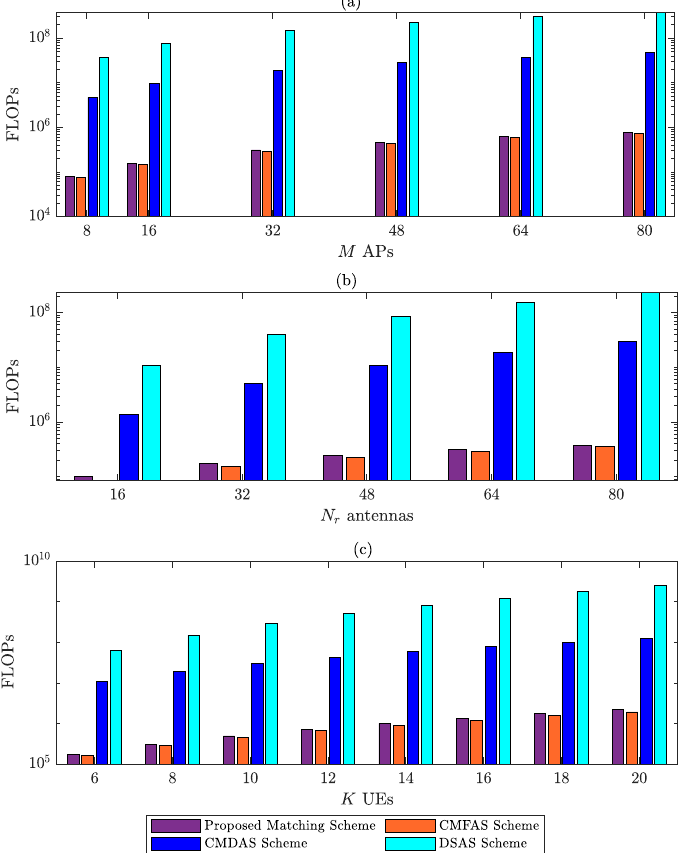
Figure 9. Complexity analysis based on floating-points operations (FLOPs) with different scenarios of uplink cell-free mm-Wave massive MIMO systems. ( a ) FLOPs versus M APs for a system with N r = 48, K = 8, ρ = 23 dBm, and N Q = 8 CPSs. ( b ) FLOPs versus N r antennas with M = 80, K = 8, ρ = 23 dBm, and N Q = 8 CPSs. ( c ) FLOPs versus the number of K UEs with, M = 80, N r = 48, ρ = 23 dBm, and N Q = 8